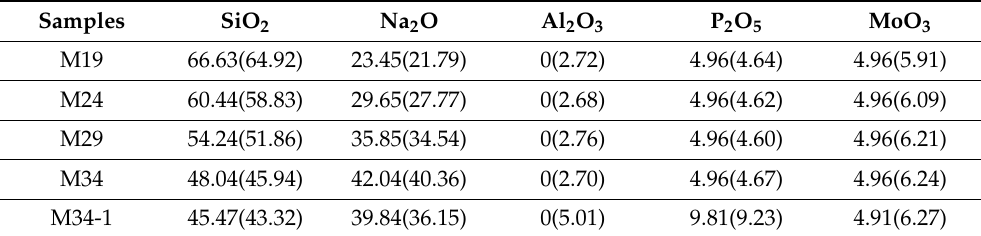
Table 3. Nominal (measured) compositions (mol%) of the glass samples (M19, M24, M29, M34, and M34-1